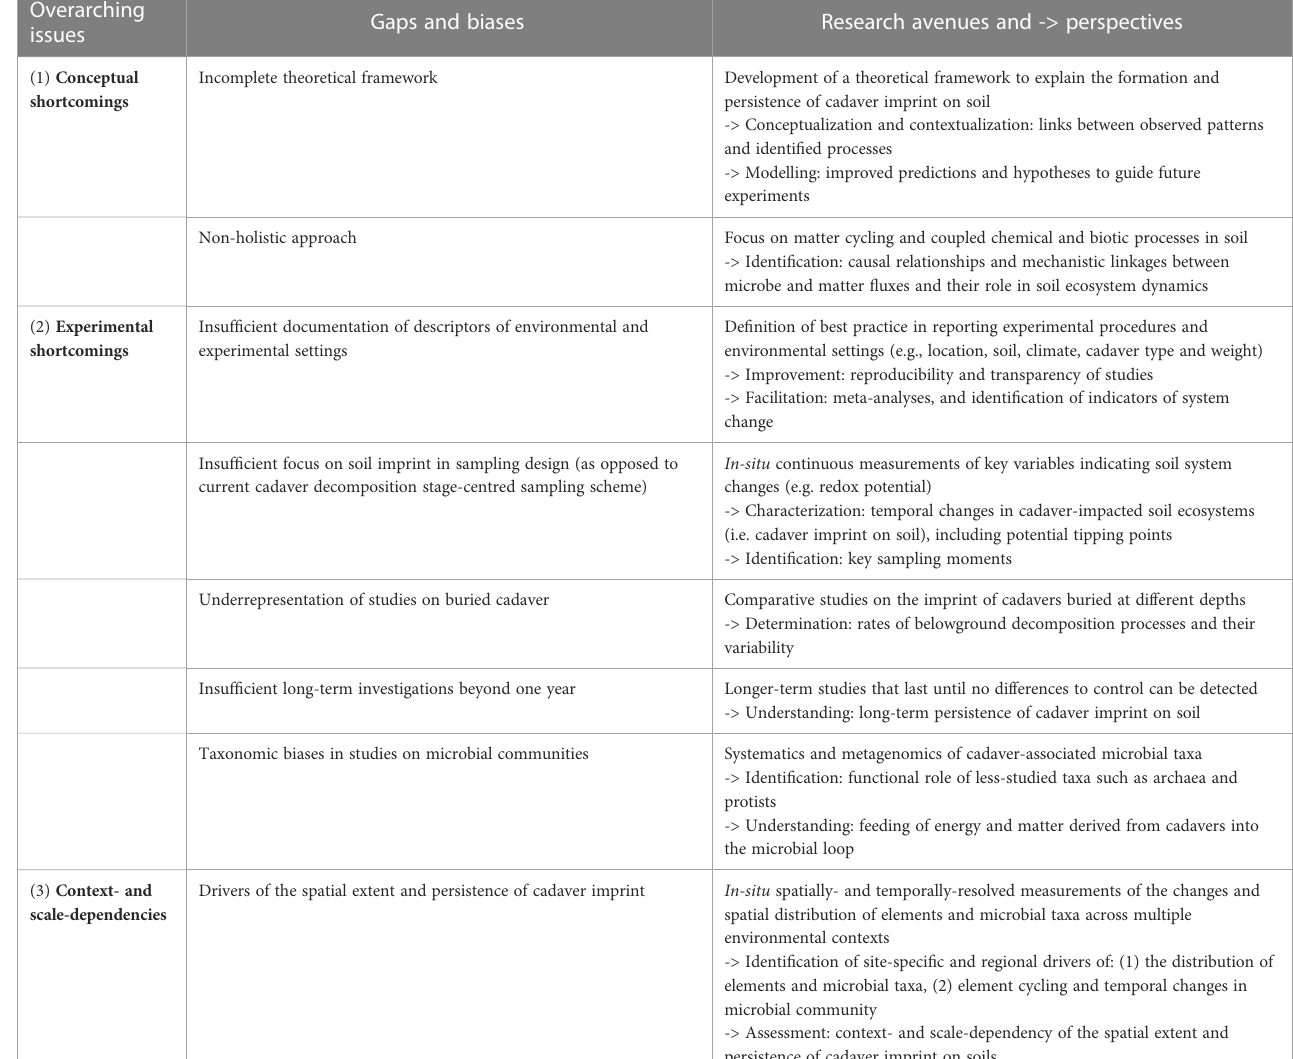
TABLE 1 Identi fi ed gaps and biases in studies on the imprint of cadaver-derived biomass on soil ecosystems.